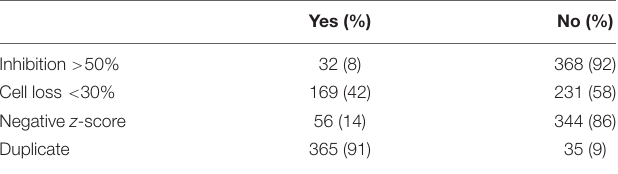
TABLE 1 | Criteria used to filter screen hits.